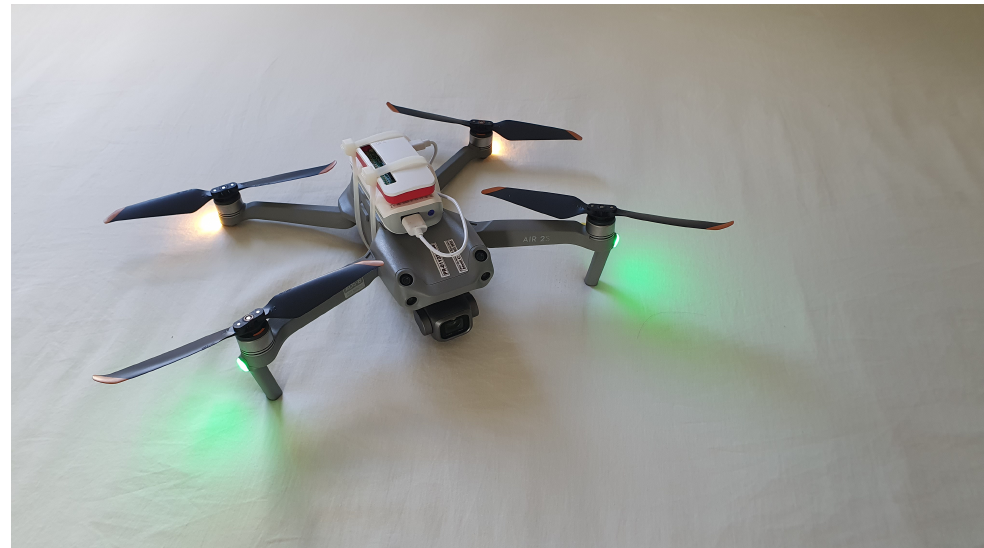
Figure 8. Drone attached to the Raspberry Pi Zero 2W.